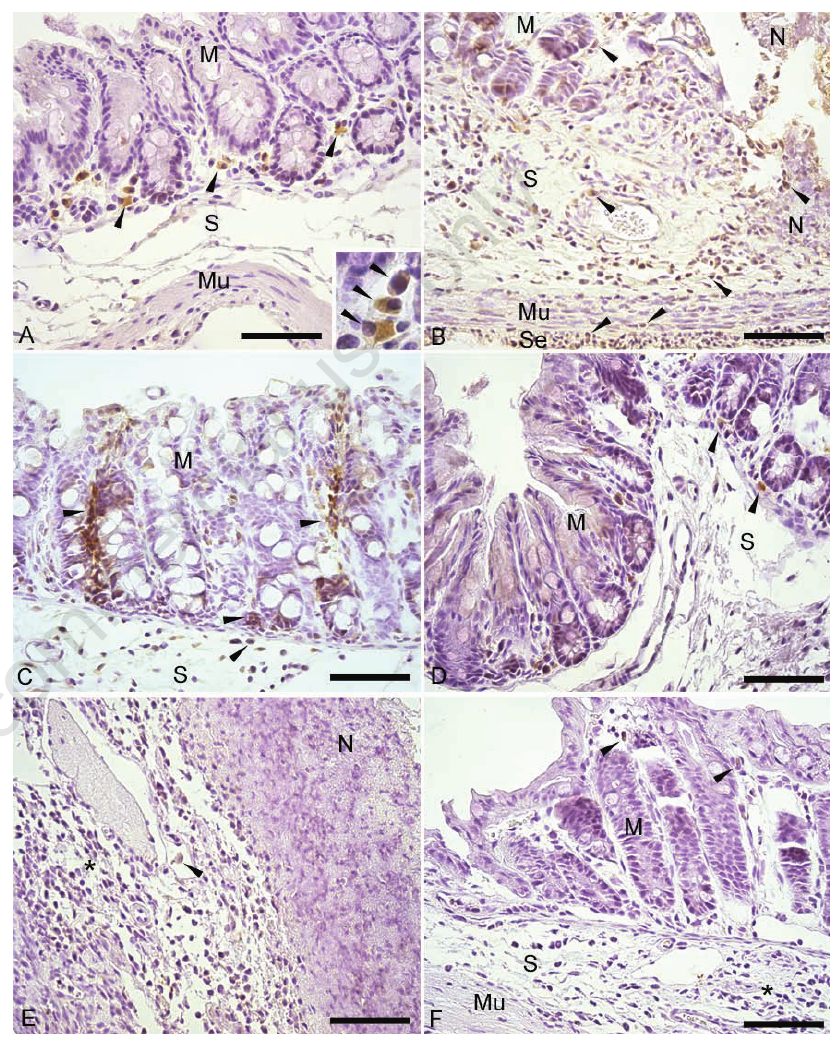
Figure 5. Immunohistochemical reaction for natural killer (NK) 1.1 + lymphocytes in the caeca of C57BL/6 wild type and C57BL/6CD1 -/- mice inoculated or not with trophozoites of Entamoeba histolytica . A) non-infected-wild type group: NK1.1 + lymphocytes with brown cytoplasms indicating positive staining (arrowheads). The insert shows NK1.1 + lymphocytes (arrowheads); B) Entamoeba-wild type group: note the presence of several NK1.1 + lymphocytes in mucosal, submucosal, muscular and serosal layers, necrosis (N); C) Entamoeba-wild type group: large number of NK1.1 + lymphocytes in preserved mucosa and submucosa; D) non-infected-CD1 -/- group: scarce NK1.1 + lymphocytes (arrowheads) in the mucosa; E) Entamoeba-CD1 -/- group: NK1.1 + lymphocytes (arrow- head) among the inflammatory infiltrate of the submucosa. Necrosis (N); F) Entamoeba- CD1 -/- group: area of preserved mucosa with scarce NK1.1 + lymphocytes (arrowheads). Inflammatory infiltrate (*) in the submucosa. Counter-staining with Harris haema- toxylin. Bar = 30 µm. M, Mucosa M; S, Submucosa, Mu, Muscular; Se,